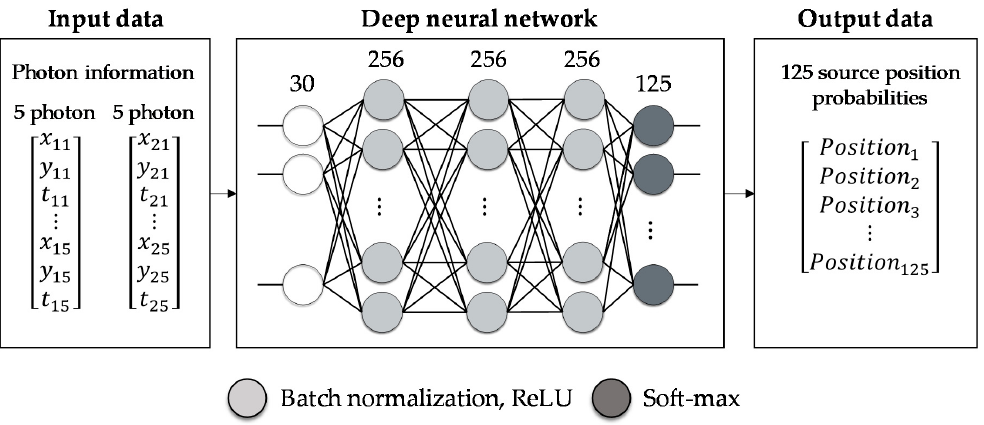
Figure 2. Multi-layer perceptron (MLP) architecture for direct classification of annihilation position from photon information measured by paired Cherenkov detectors.